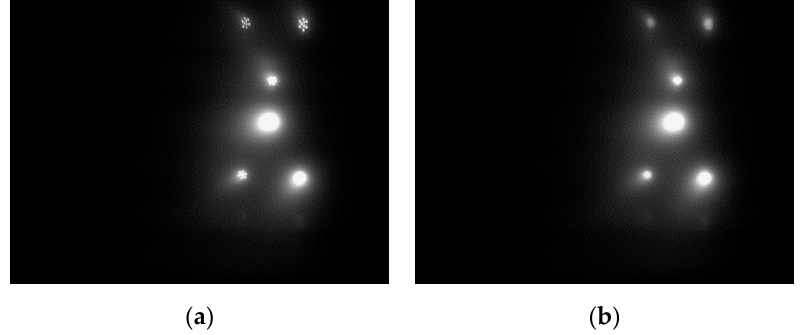
Figure 4. Effect of image filtering: ( a ) the raw image; ( b ) the processed image using the median filter.